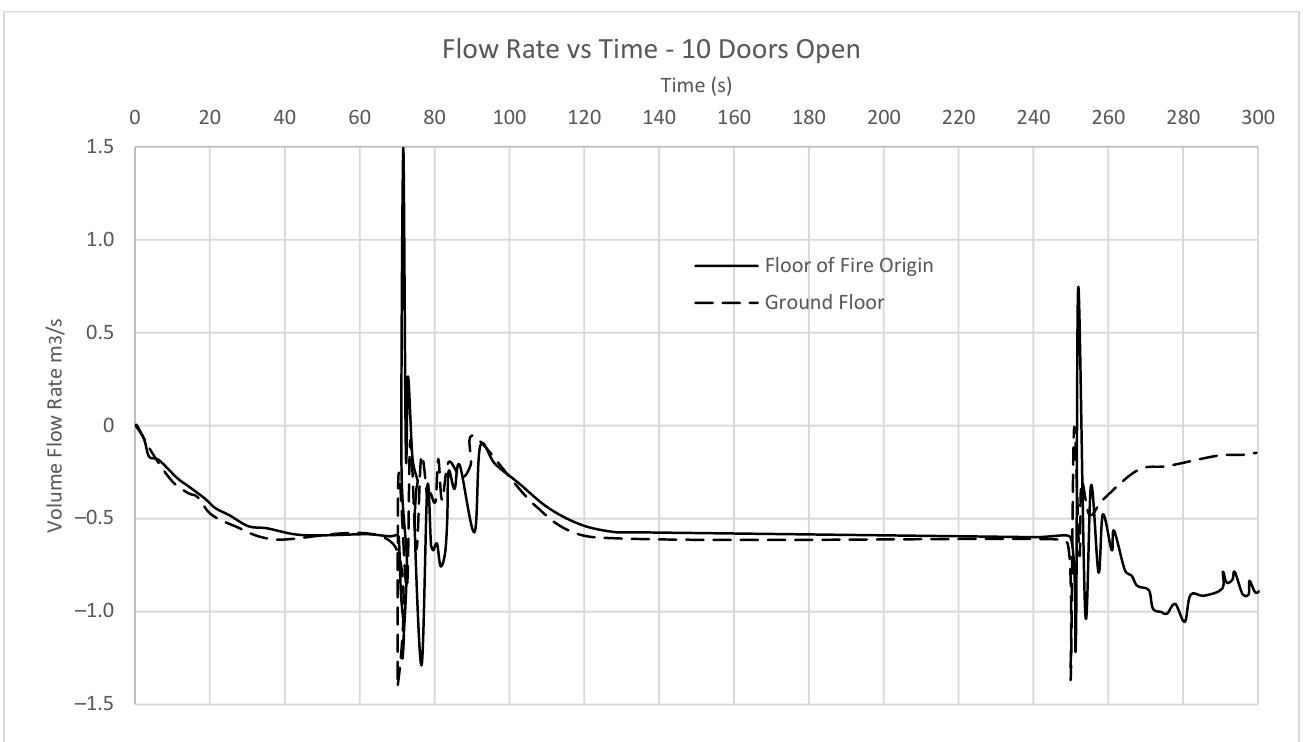
Figure 14. Volume flow rates through the ground floor door and floor of fire origin with 10 doors open into the shaft.